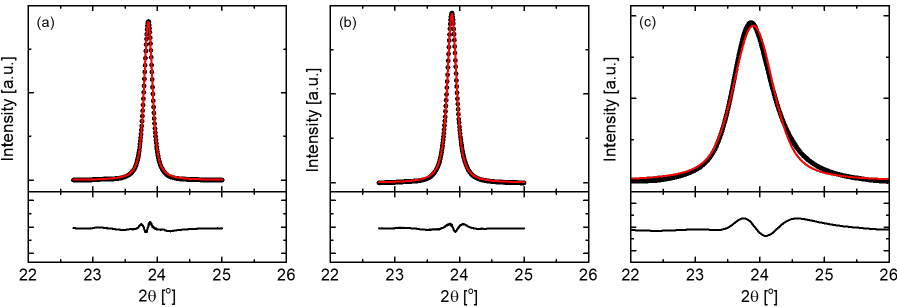
Figure 6. XRD analysis of (111) diffraction peak corresponding to the CdTe thin film deposited by VTE ( a ) and RF-MS ( b ) on a pristine optical glass and by ECD ( c ) on an Si substrate coated by a thin Au film. The experimental data (black dots) were fitted with Voigt profiles (red curves), with the residual of this procedure presented at the bottom of each graph. Table 2. Structural parameters of CdTe thin films deposited by VTE, RF-MS, and ECD, as quantita- tively obtained by analytic fitting of the XRD experimental data using the Voigt profile; D the crystalline coherence length determined from the analysis of (111) crystalline plane, (cid:104) ε 2 (cid:105) 1/2 is the mean square micro-strain, and a represents the lattice